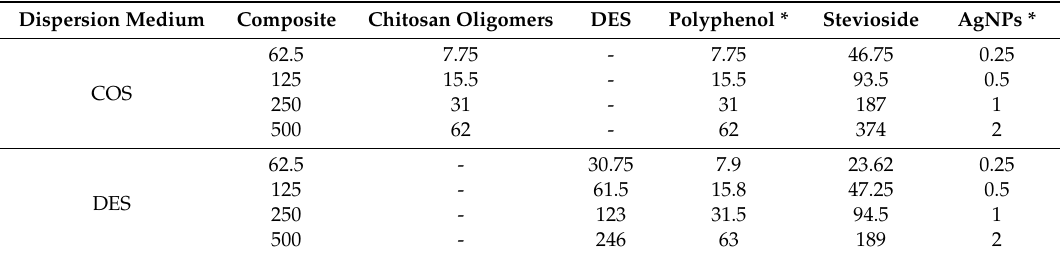
Table 4. Equivalent concentrations (in µ g · mL − 1 ) of each of the individual components in the bioactive composites under